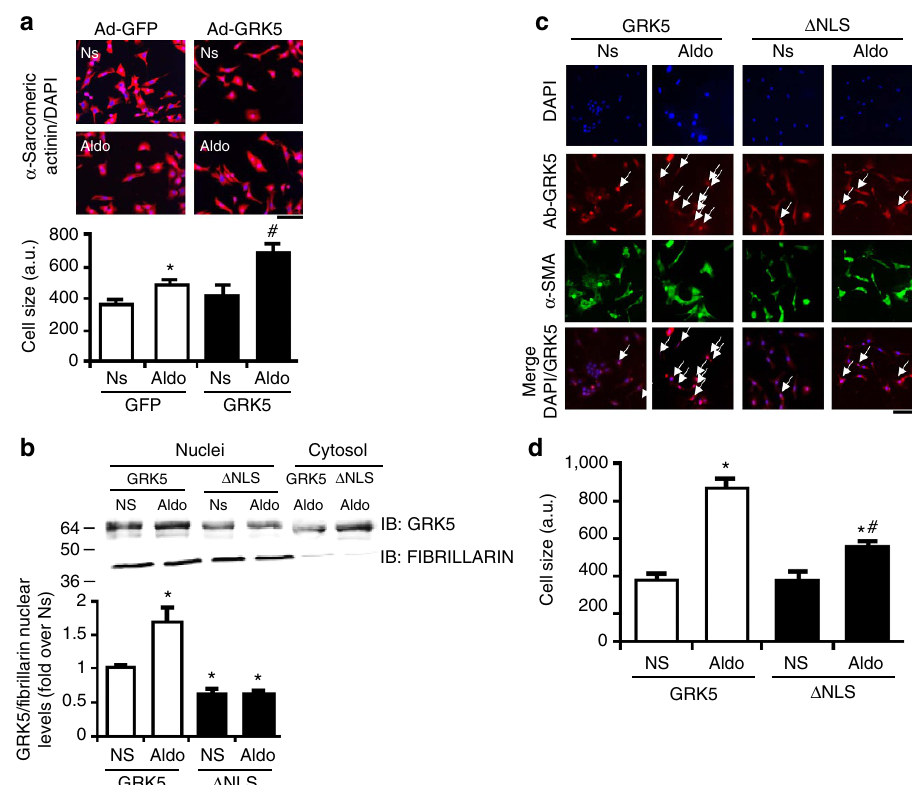
Figure 5 | Nuclear GRK5 localization induces hypertrophic response in NRVMs. ( a ) Representative images and bar graphs showing hypertrophic response ( a -sarcomeric actinin staining) in NRVMs ( B 200 cells analysed for the group for each experiment) infected with Ad encoding for GFP or GRK5. The cells were Ns or stimulated with Aldo (1 m M) for 48h; * P o 0.05 versus GFP Ns; # P o 0.05 versus GFP Aldo; scale bar, 50 m m. ( b ) Representative immunoblots (upper panels) and densitometric analysis (lower panel) of multiple independent experiments ( n ¼ 3) to evaluate GRK5 levels in nuclear fractions purified from NRVMs infected with an Ad-GRK5 or an Ad-GRK5- D NLS. NRVMs were Ns or stimulated with Aldo (1 m M) for 30min. FIBRILLARIN was used as loading control; * P o 0.05 versus Ns. ( c , d ) Representative panels of DAPI (blue), GRK5 (red) and a -sarcomeric actinin staining ( a -SMA) immunofluorescence images (scale bar, 50 m m) and ( d ) bar graphs showing cumulative data of multiple independent experiments ( n ¼ 3) to evaluate hypertrophic response in NRVMs ( B 200 cells analysed for the group for each experiment) infected with Ad encoding for GRK5 or GRK5- D NLS. The cells were Ns or stimulated with Aldo (1 m M) for 48h; arrows in GRK5 and in merged (DAPI/GRK5) panels indicate the nuclear localization of GRK5. * P o 0.05 versus GRK5 Ns; # P o 0.05 versus GRK5 Aldo. ( a , b , d ) Statistical significance between groups was determined by one-way ANOVA with Bonferroni post hoc correction. All data are shown as mean ± s.e.m.